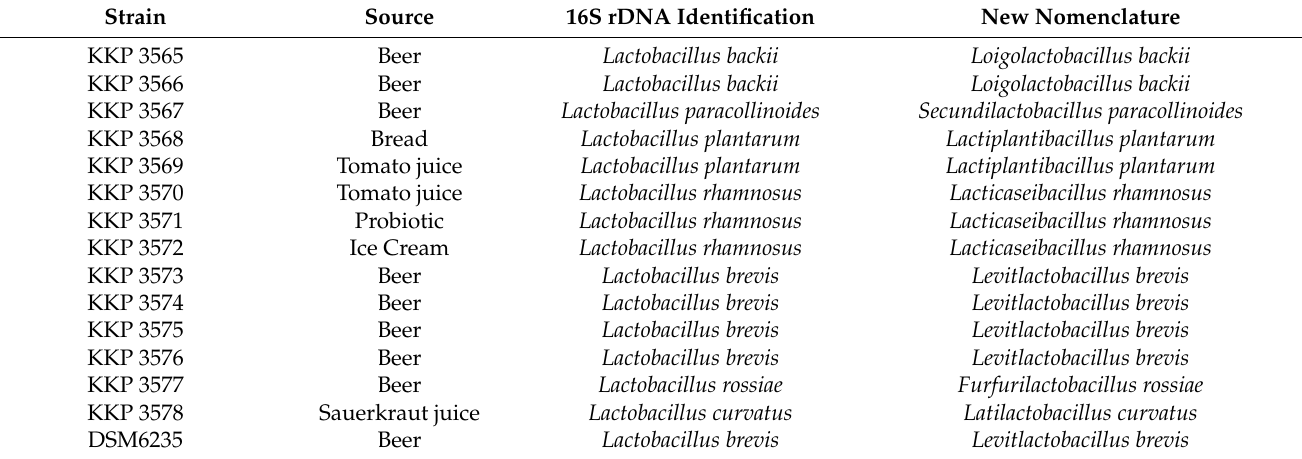
Table 1. The list of studied lactic acid bacteria with the additional new nomenclature. Strain Source 16S rDNA